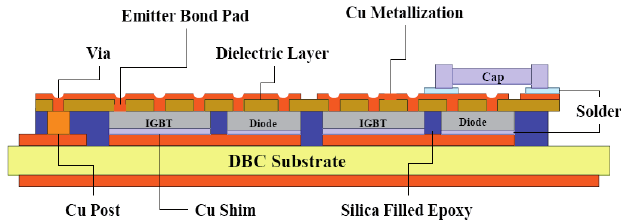
Fig. 6. Power Overlay Technology (General Electric –